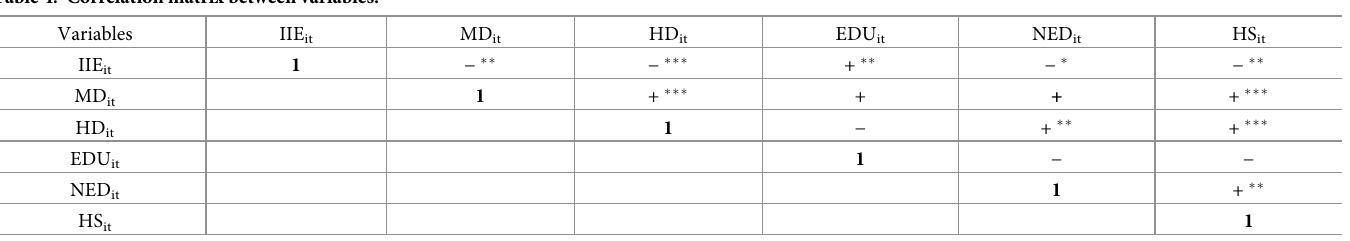
Table 4. Correlation matrix between